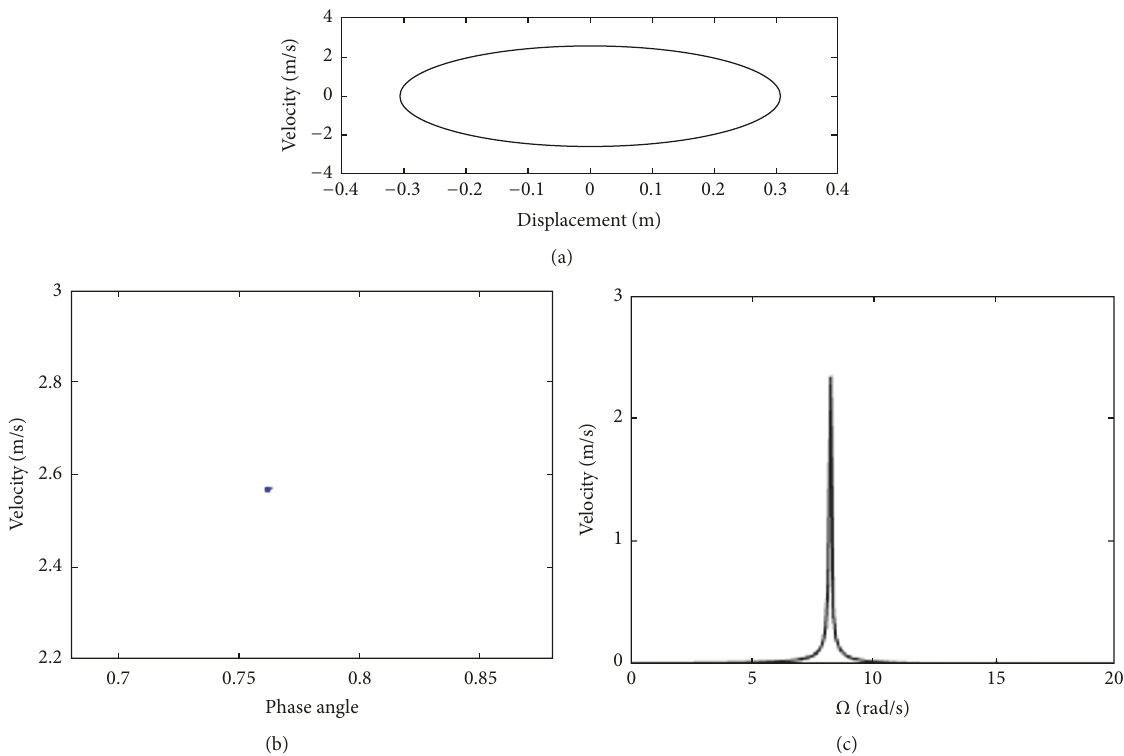
Figure 9: The period-one orbit at Ω = 8.2 rad/s: (a) the phase portrait, (b) the Poincar´e map, and (c) the frequency spectrum.